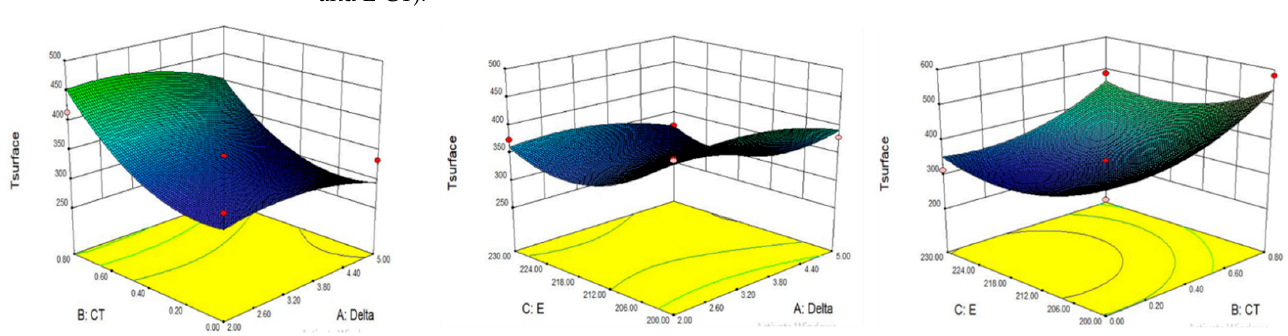
Figure 14. Comparative analysis of maximum von-Mises stress (response to CT-delta; E-Delta and E-CT).